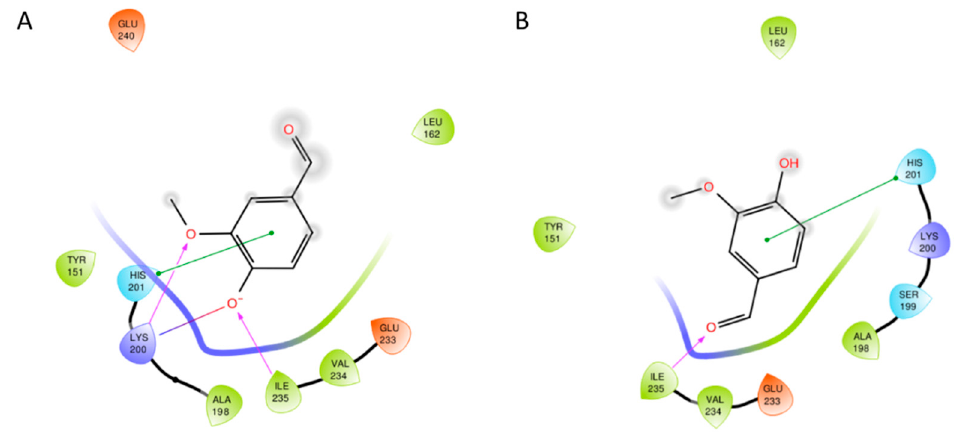
Figure 6. Binding mode of vanillin ( 8 ) to human pancreatic α -amylase according to its anionic ( A ; Gscore = − 3.70 kcal / mol) and neutral ( B ; Gscore = − 5.59 kcal / mol) form. Salt bridge interaction is depicted with a continuous blue / red faded line. Hydrogen bonds are shown with magenta arrows. ‐ π -Stacking interaction is plotted with a green capped line. Polar and hydrophobic contacts between ligand and enzyme residues are displayed with blue and green faded tick lines, respectively.